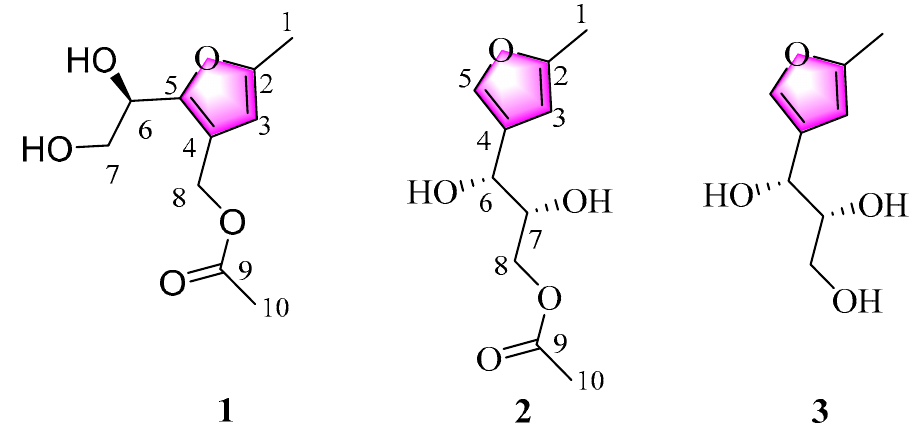
Figure 1. Chemical structures of compounds 1 – 3